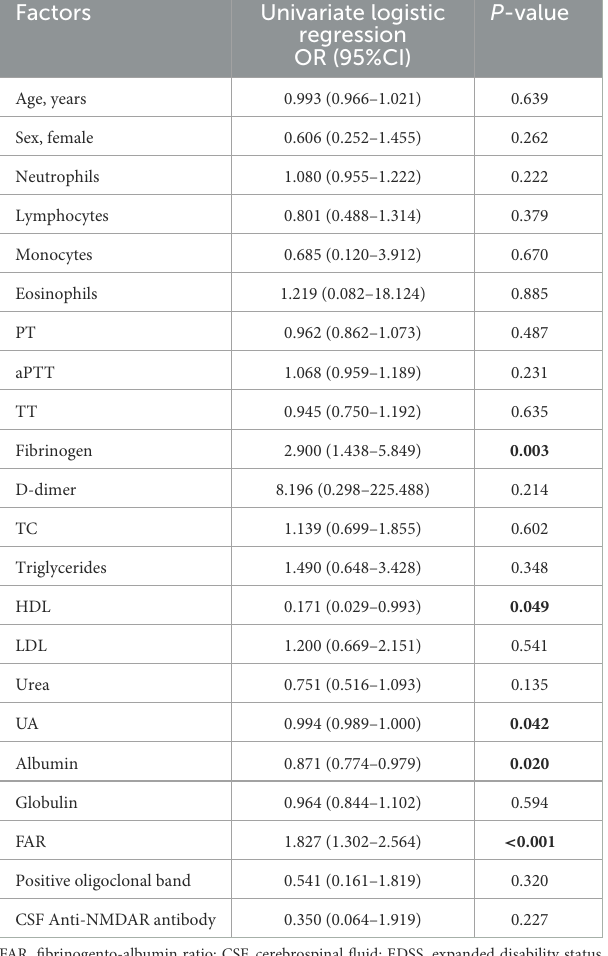
TABLE 6 Univariate logistic regression for assessing the association of fibrinogen-to-albumin ratio with disease severity. Factors